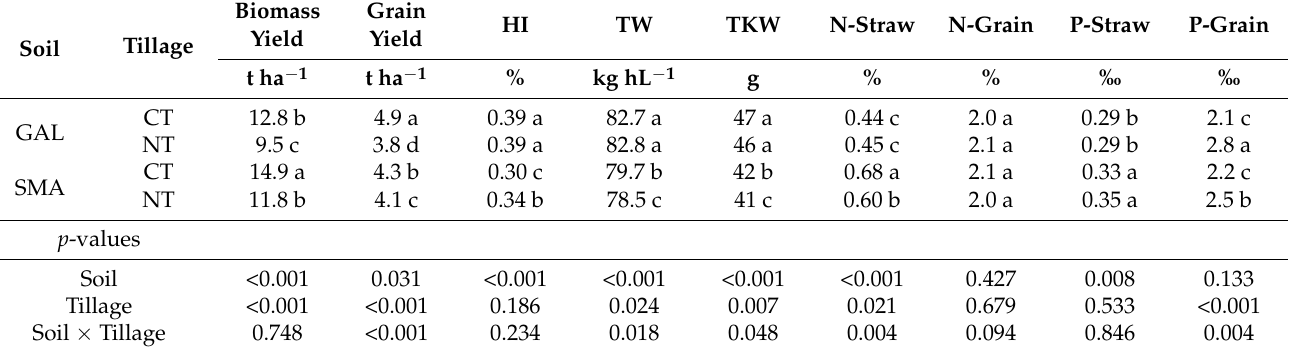
Straw P concentration (P-Straw) exhibited a significant difference only among soils with higher val- ues in SMA (+17%), while P grain concentration (P-Grain) was affected by the interaction soil × till- age with higher values retrieved in GAL (2.45‰ vs. 2.34‰) and, among managements, under NT (+26% than CT on average) (Table 1).